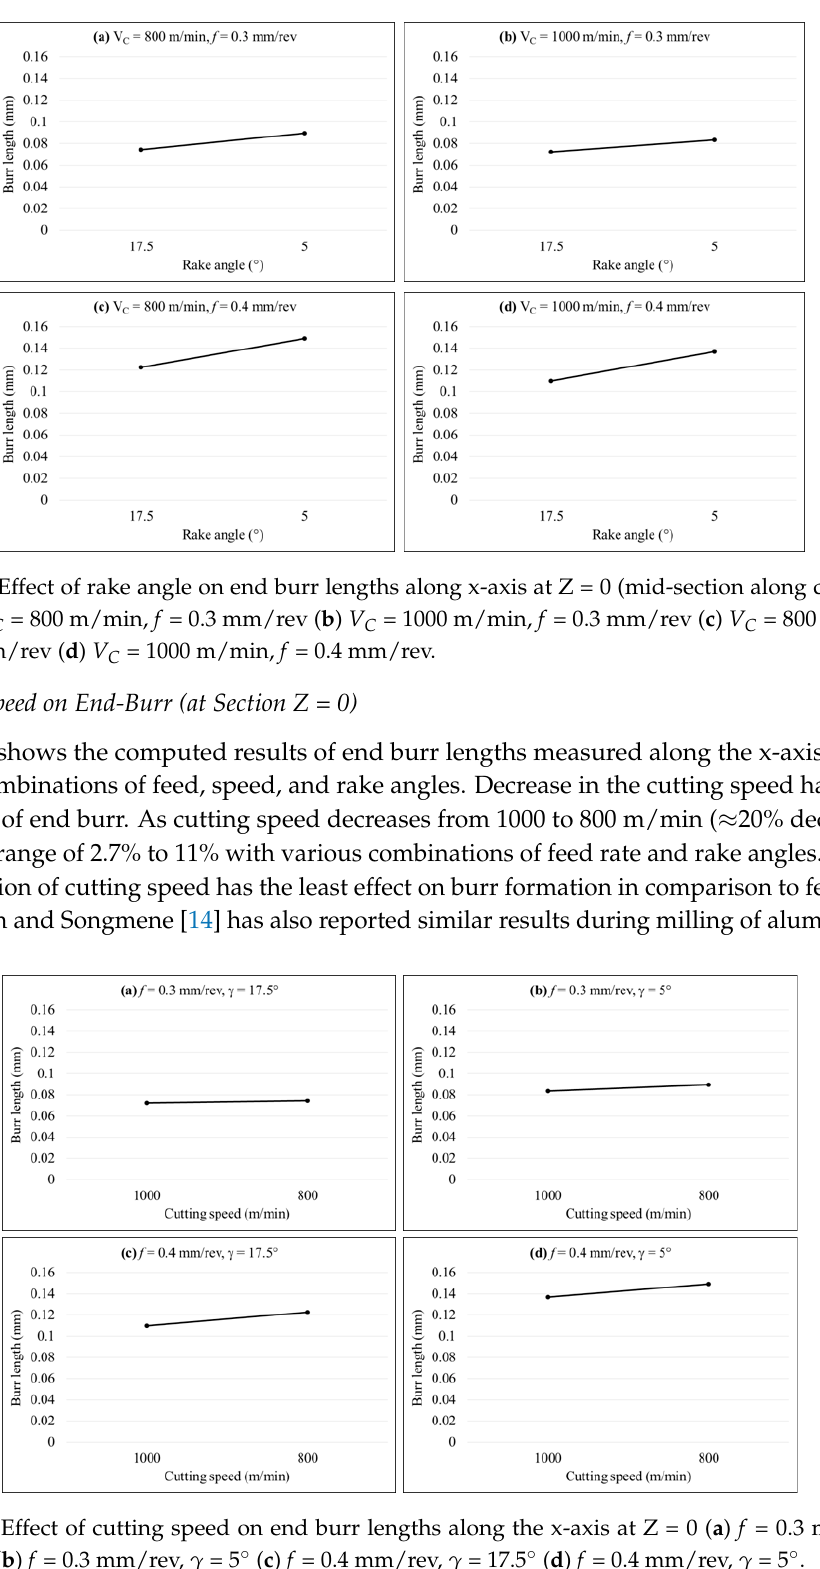
Figure 8. Effect of cutting speed on end burr lengths along the x-axis at Z = 0 ( a ) f = 0.3 mm/rev, γ = 17.5 ◦ ( b ) f = 0.3 mm/rev, γ = 5 ◦ ( c ) f = 0.4 mm/rev, γ = 17.5 ◦ ( d ) f = 0.4 mm/rev, γ = 5 ◦